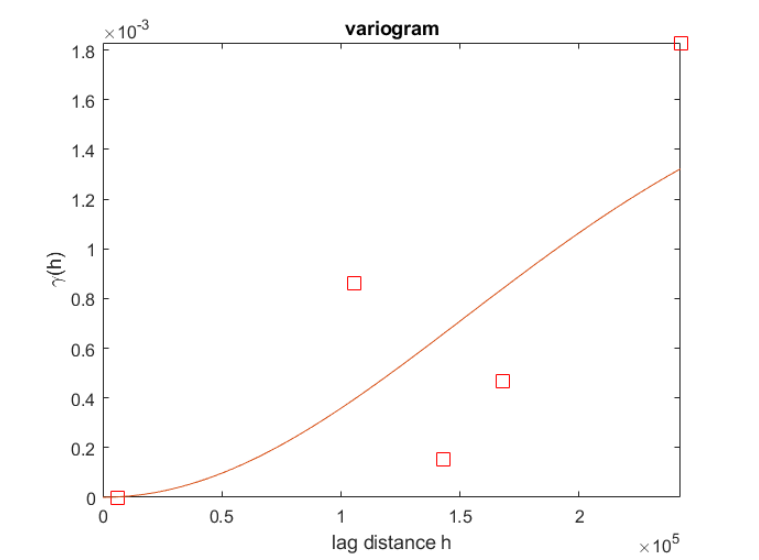
Figure 4. Sample variogram for the network (squares symbols) with the fitted model (solid curve).